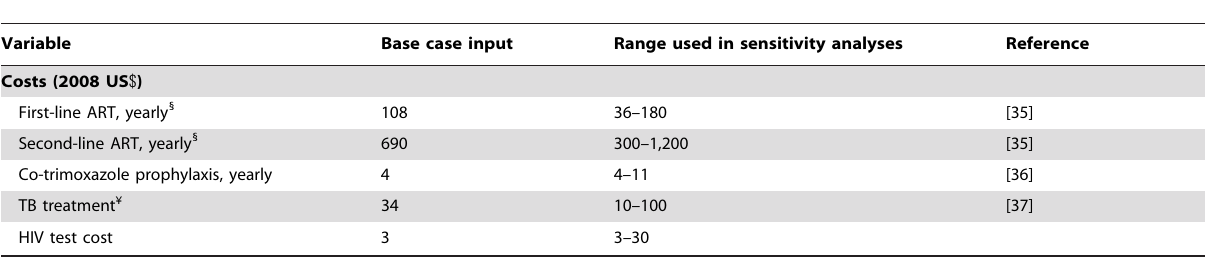
Table 4. Cost inputs for an analysis of HIV testing for TB patients in India.